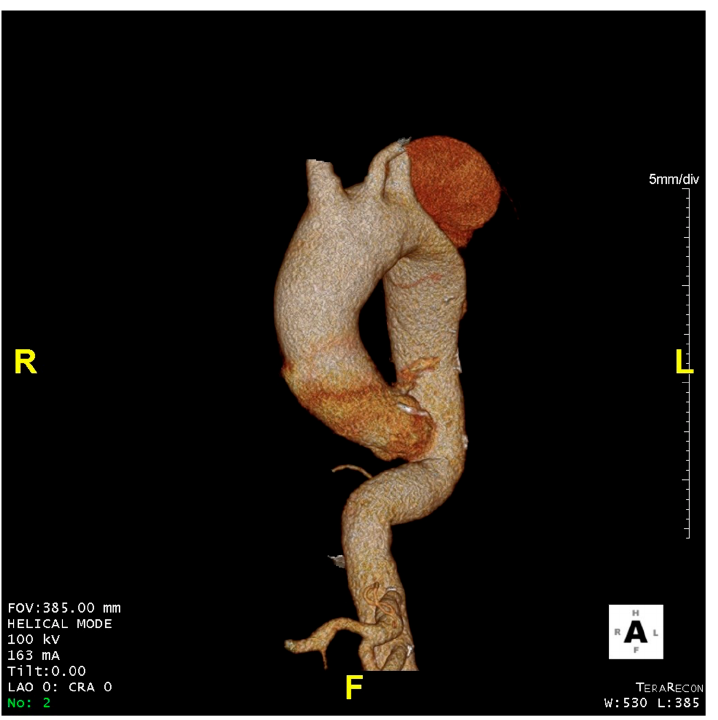
Figure 2. Patient 6. Aneurysm of the ascending aorta and distal aortic arch (8 cm) in previous acute type B aortic dissection treated conservatively.